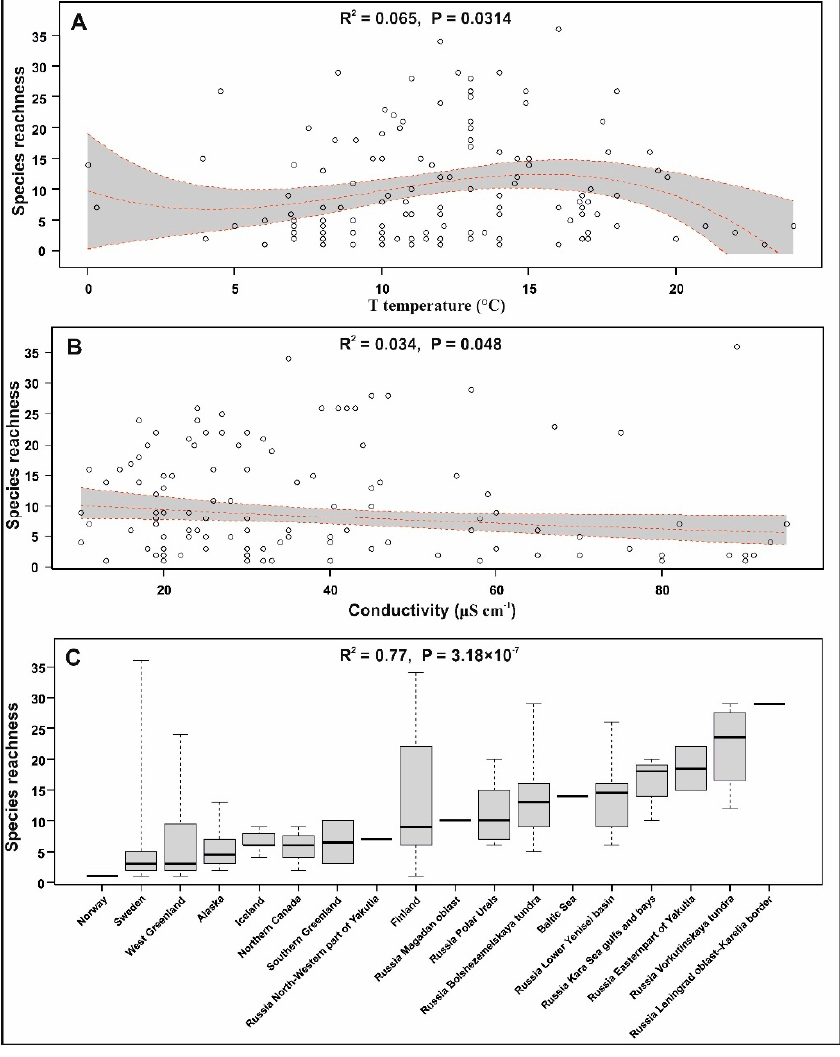
Figure 6. Impact of qualitative abiotic factors on species richness. A) Dependence of the species richness on water temperature (T) described by third degree polynomial (species richness = − 19.65 × T 3 − 14.9 × T 2 + 6.83 × T + 10.07); circles show data of real observations, central dashed line shows the main dependence, upper and lower dashed line and gray sector show the 96% confidence in ‐ terval. B). Dependence of the species richness on conductivity described by a linear function (spe ‐ cies richness = − 0.04 × conductivity + 12.04); circles show data of real observations, central dashed line shows the main dependence, upper and lower dashed line and gray sector show the 96% con ‐ fidence interval. C) Dependence of the species richness on sampling region factor visualized as boxplots.